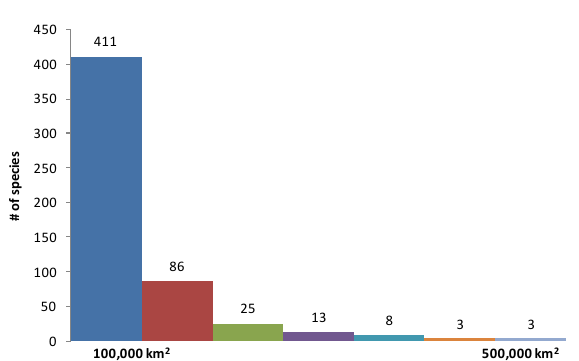
Figure 1. Range size for Mexican freshwater